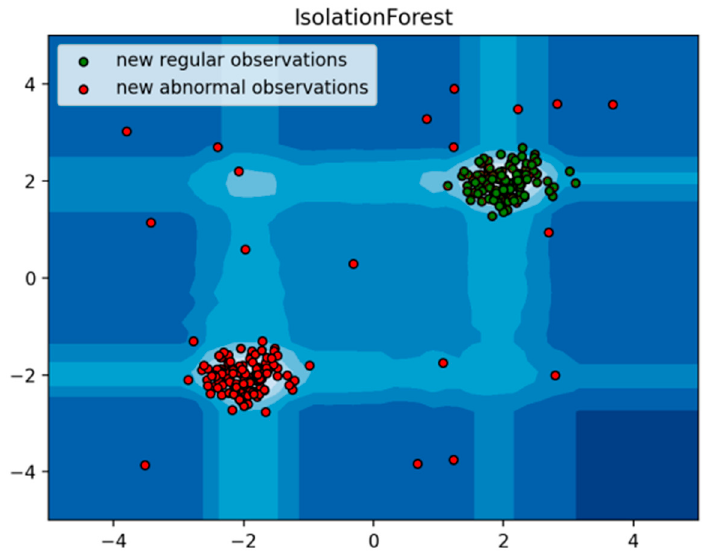
Figure 2. On the phenomenon of clustering of anomalies in isolated forest.